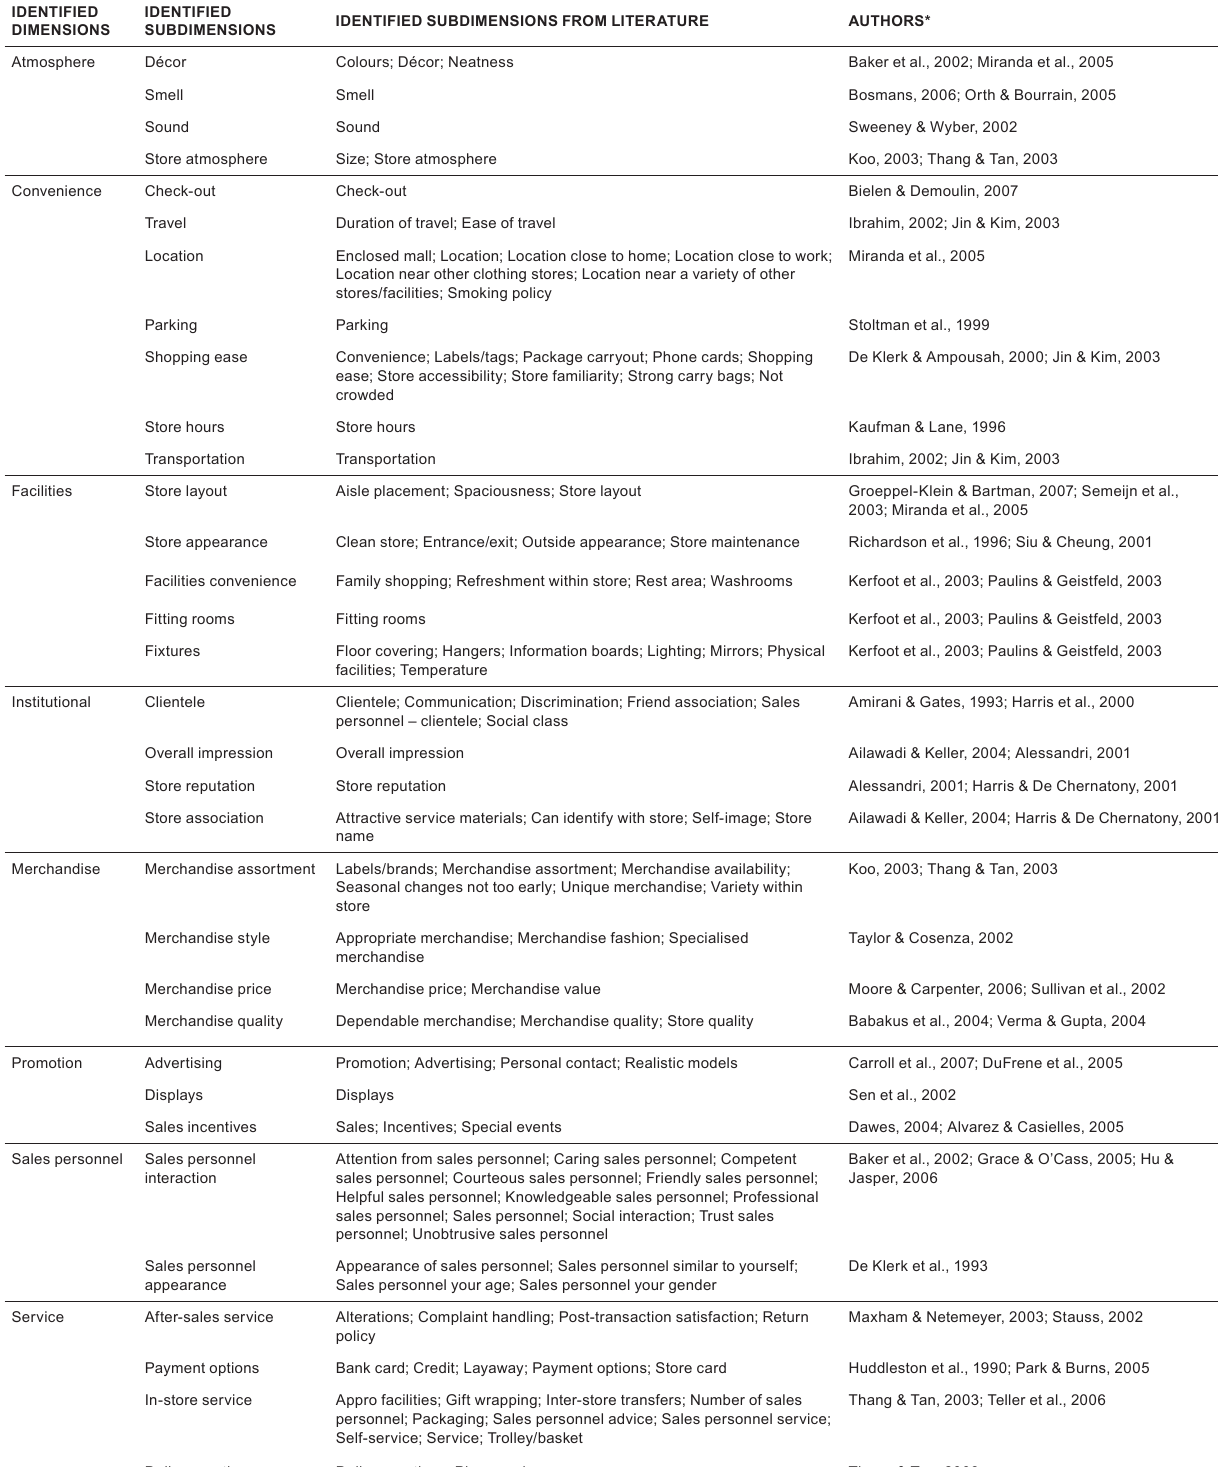
TABLe 2 Store image subdimensions identified from the